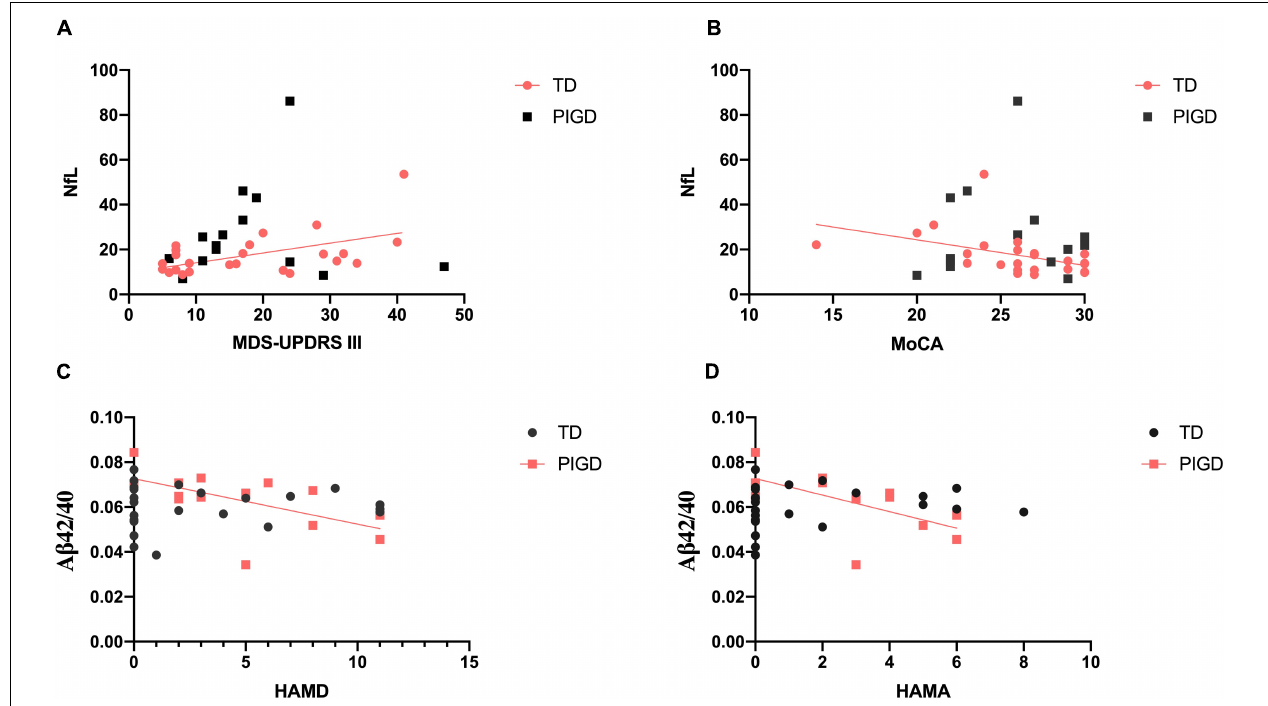
FIGURE 1 | Correlations between plasma biomarkers and clinical features in patients with PD. There were significant relationships between plasma NfL and MDS-UPDRS III (A) and MoCA (B) in the TD group. Plasma A β 42/40 level was negatively correlated with HAMD (C) and HAMA (D) in PIGD. Significant correlation ( p < 0.05) is marked in solid red line.